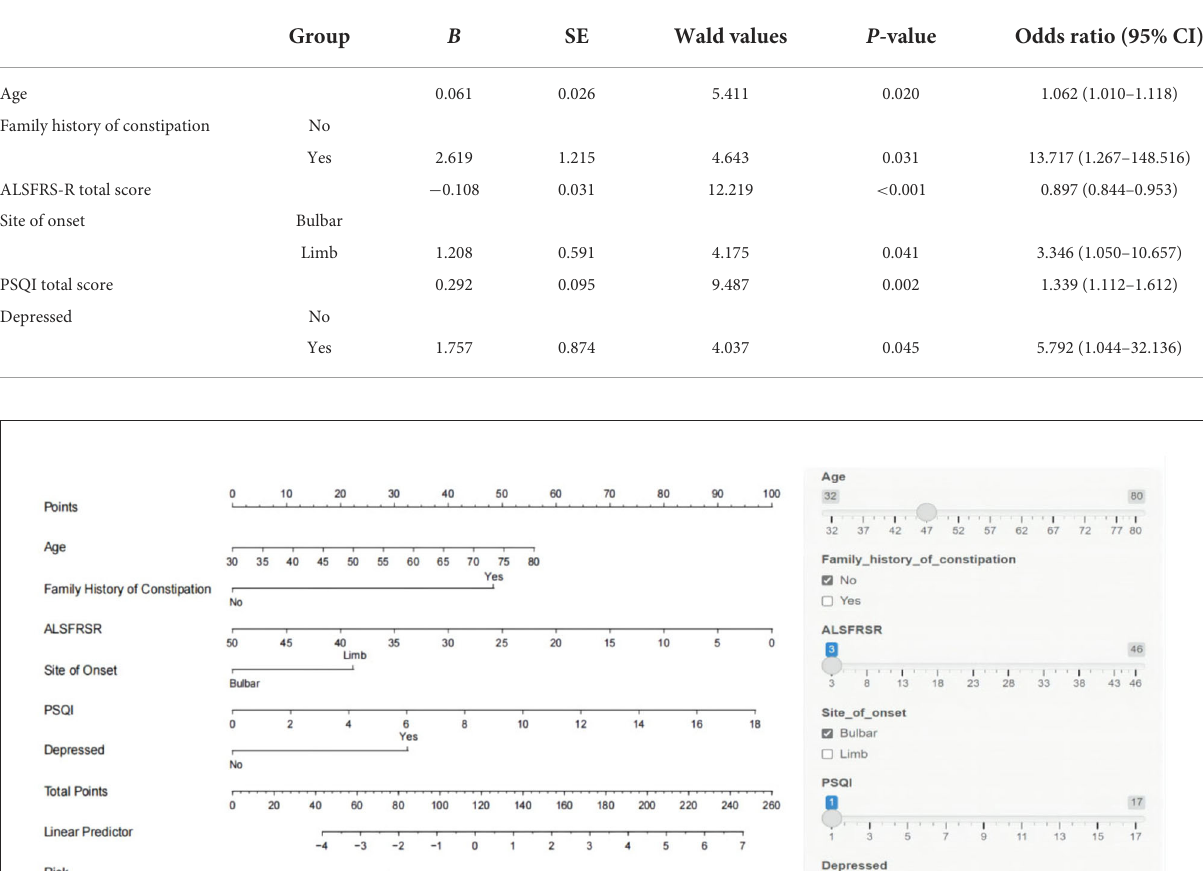
TABLE 2 Logistic regression analysis of risk factors for constipation in ALS patients.